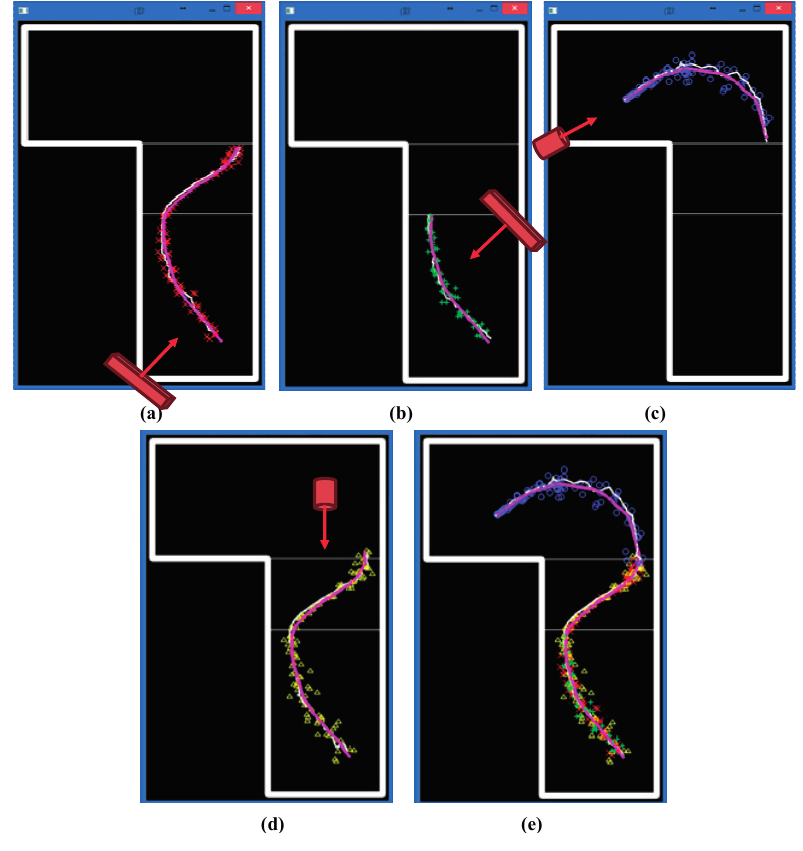
Figure 8. Measurements of distinct sensors: ( a ) red cross mark for Kinect#1; ( b ) green plus mark for Kinect#2; ( c ) blue circle mark for color#1; ( d ) yellow triangle mark for color#2; ( e ) multisensor fusion; Thin white curve indicates the Kalman estimated trajectory, and thick purple curve represents the actual trajectory (ground